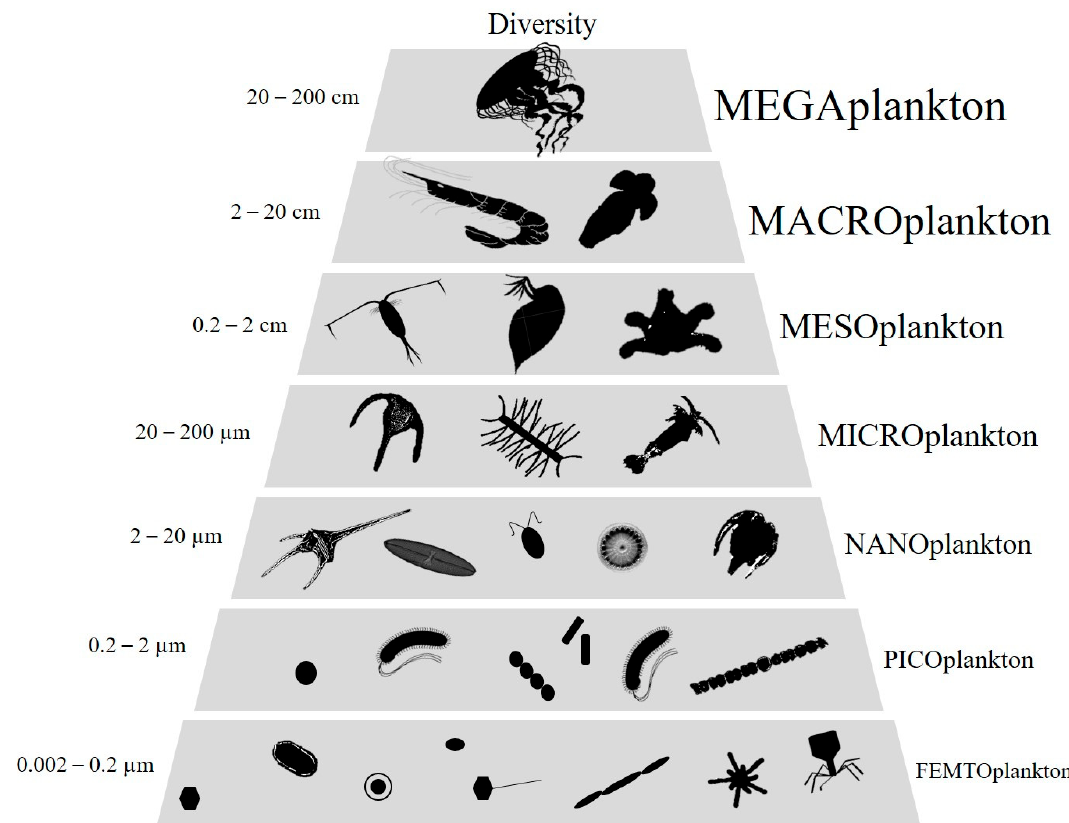
Figure 1. Schematic representation of plankton size classes (adapted from [2]).